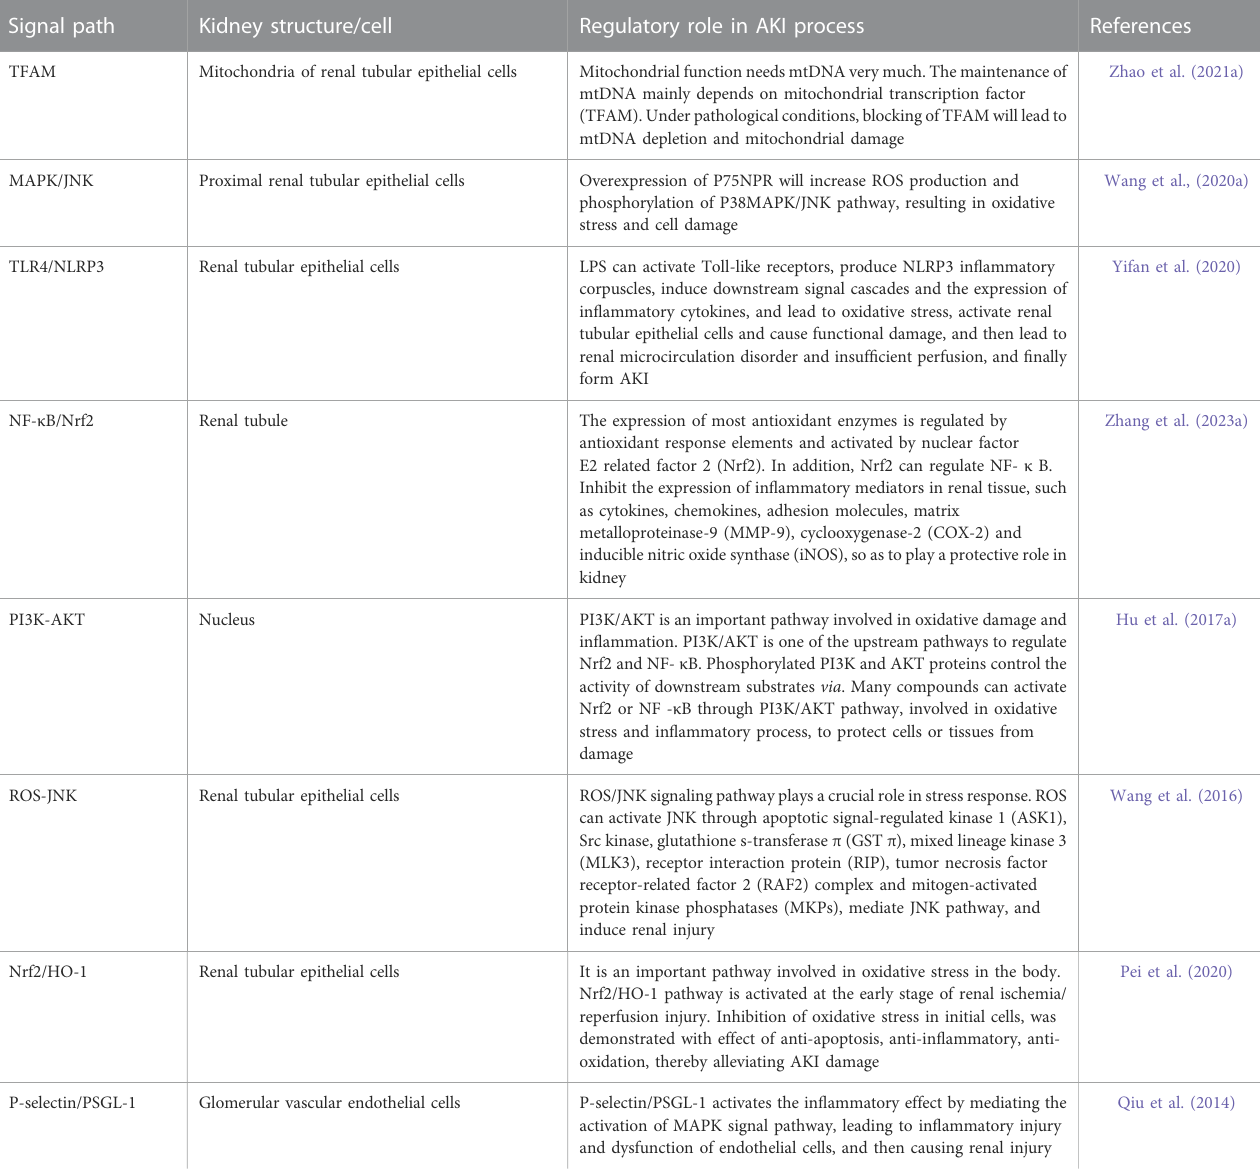
TABLE 1 Signal pathways for oxidative stress regulation in acute renal injury